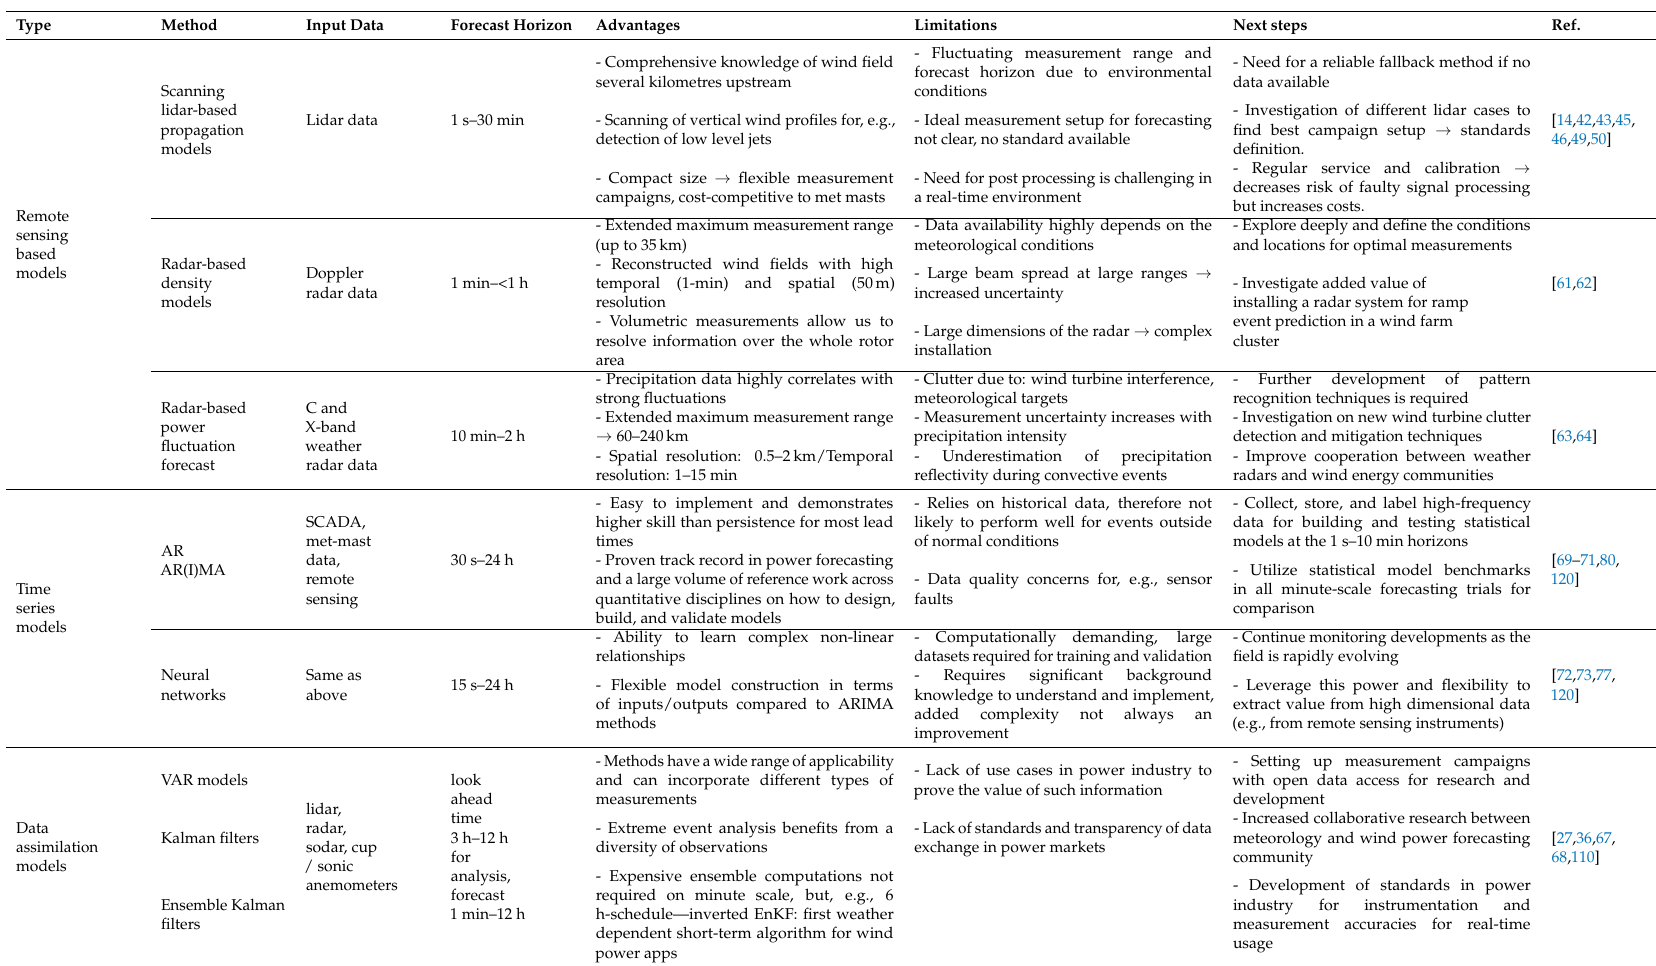
Table 4. Overview of methods for minute-scale